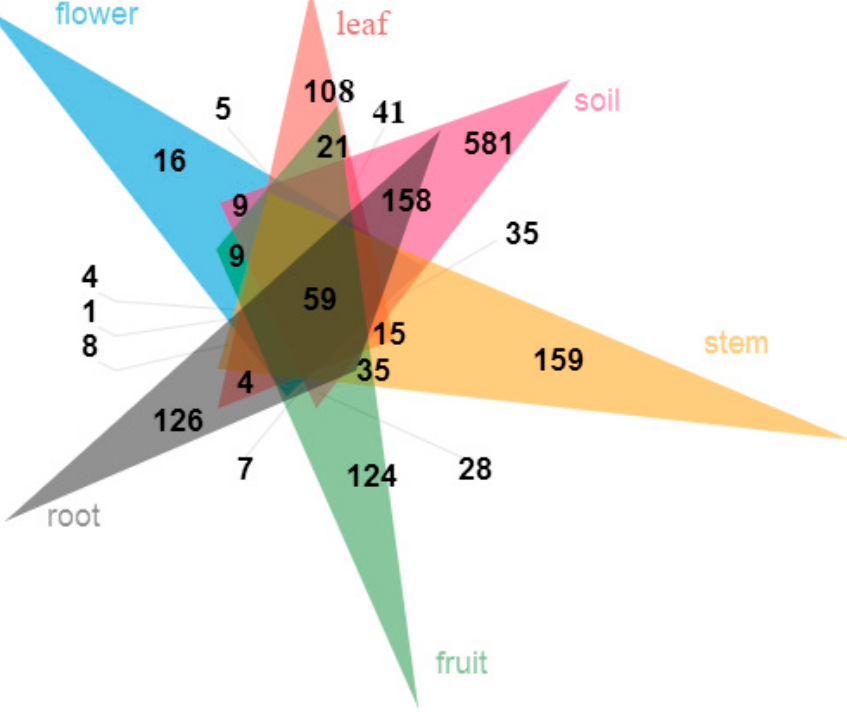
Figure 3. Venn diagram showing shared and unique fungal OTUs in each organ (flower, leaf, fruit, stem, root) and soil.